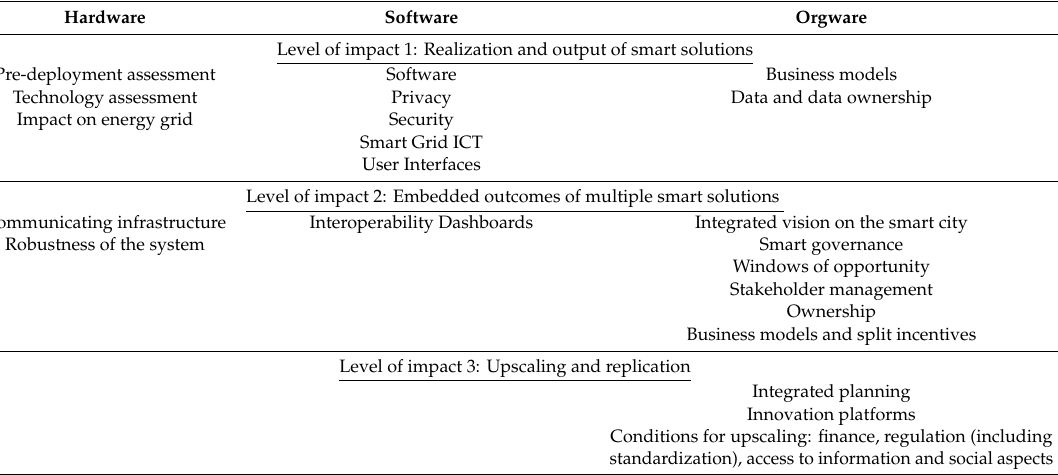
Table 1. RUGGEDISED innovation and implementation framework: enhancing and suppressing factors